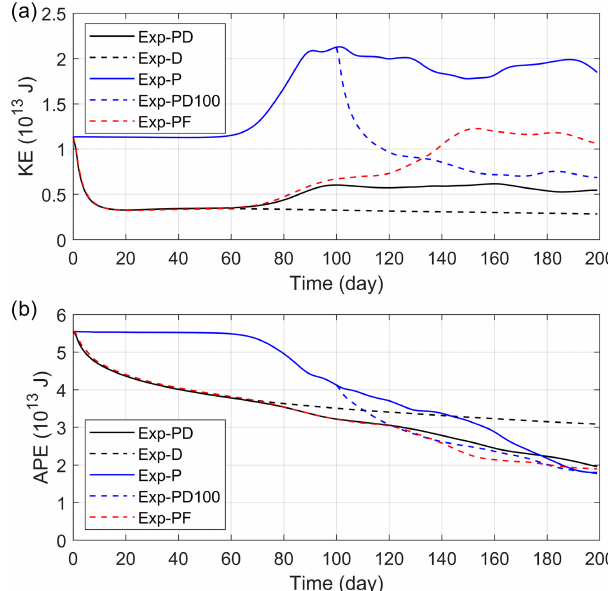
Figure 8. Time evolution of the (a) KE and (b) APE integrated over the model domain from the base and sensitivity